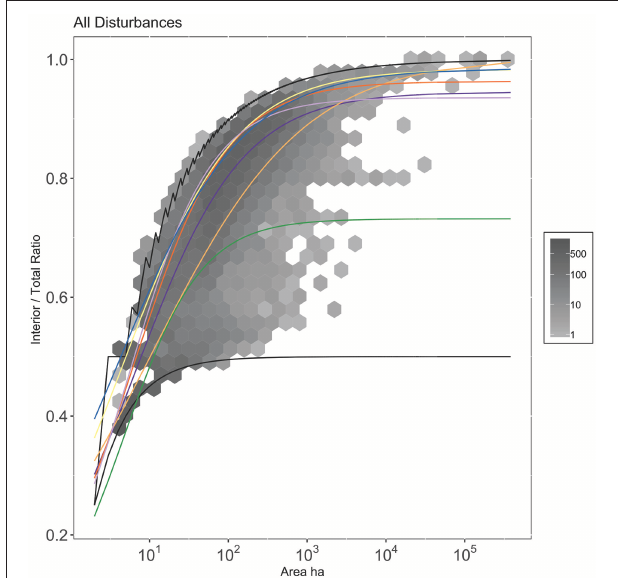
FIGURE 11 | Mean trends of disturbance type. Curves match Disturbance model curves referenced in Figure 7 . Gray hexes correspond to binned-counts of number of disturbance events. Black lines correspond to linear bounding cases. Parameter values associated with curves can be found in Supplementary Table 5 . Plots of individual curves against data can be found in Supplementary Figure 3